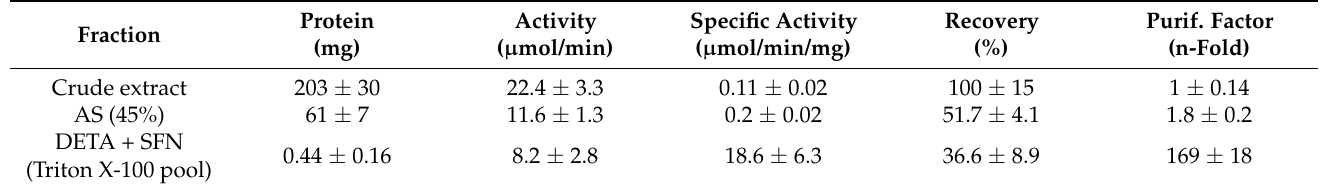
Table 1. Summary of the myrosinase purification from L. sativum swollen seeds. The enzyme activities were measured at 5 mM concentration of sinigrin under the optimal